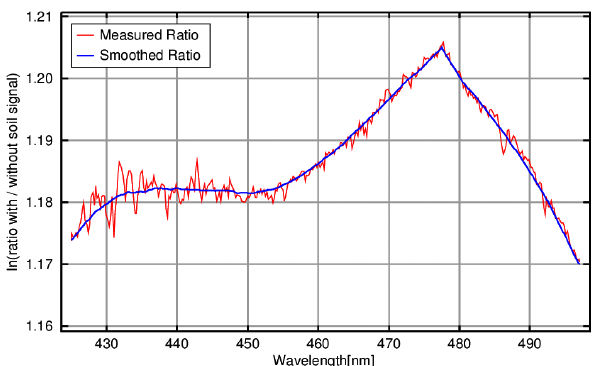
Fig. 7. Comparison of the GOME-2 soil signature with the loga- rithm of the ratio of two measurements performed with a ground- based spectrometer in Bremen, one pointing at a surface covered with sand from the Sahara and one pointing at the zenith-sky. As the overall shape of the two signals differs, a polynomial with 3 coefficients was subtracted, as it is done during the DOAS